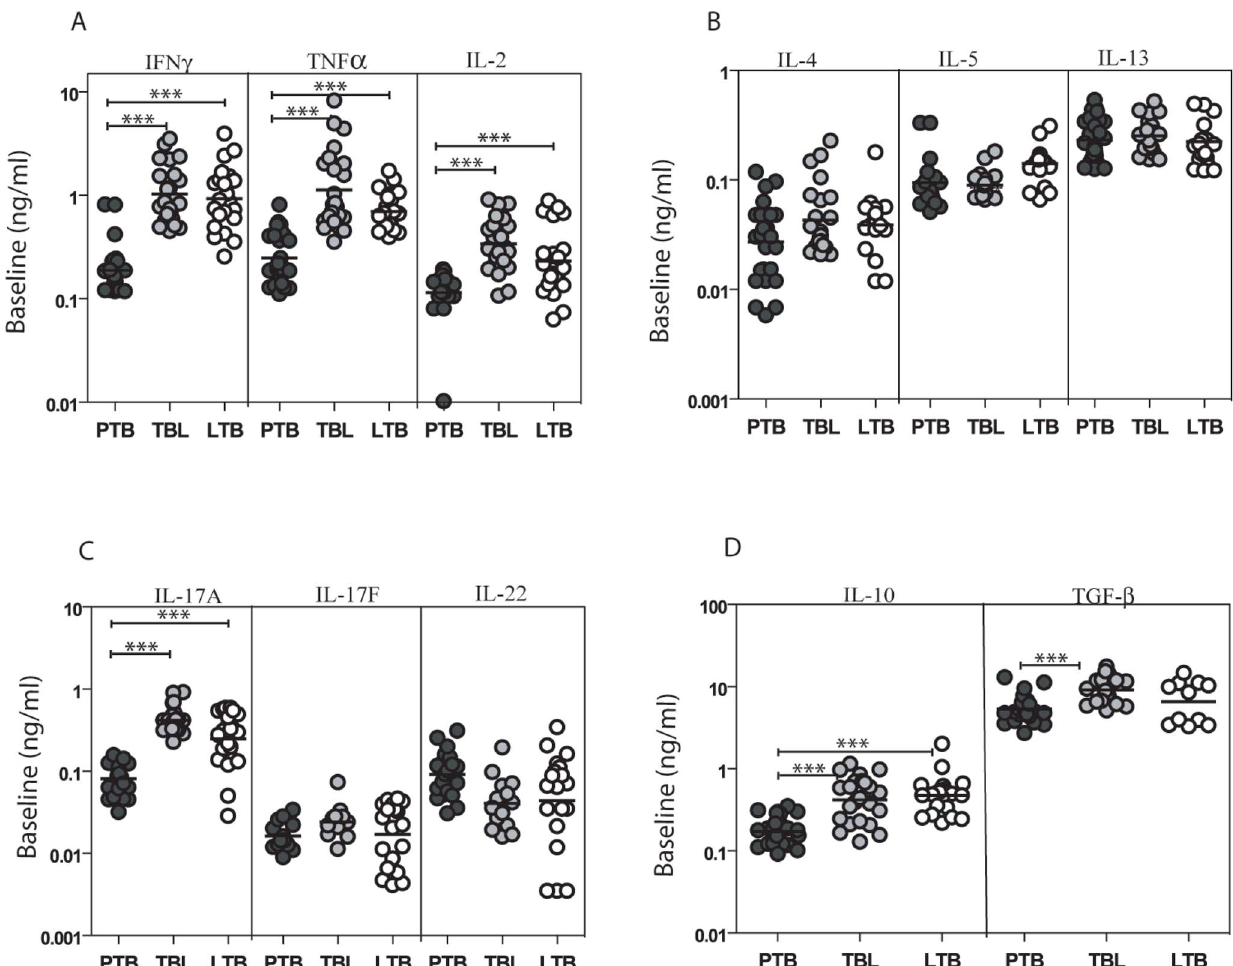
Figure 1. PTB is associated with decreased spontaneous production of Type 1, 2, 17 and immunoregulatory cytokines. Whole blood from PTB, TBL and LTB individuals was stimulated with media alone for 72 h, and levels of (A) Type 1 cytokines IFN c , TNF a and IL-2; (B) Type 2 cytokines IL-4, IL-5, and IL-13; (C) Type 17 cytokines IL-17A, IL-17F and IL-22 and (D) Immunoregulatory cytokines IL-10 and TGF b were measured by ELISA. Results are shown as scatterplots with each dot representing a single individuals. P values were calculated using the Kruskal-Wallis test with Dunn’s multiple comparisons (* p , 0.05, ** p , 0.01, *** p , 0.001).